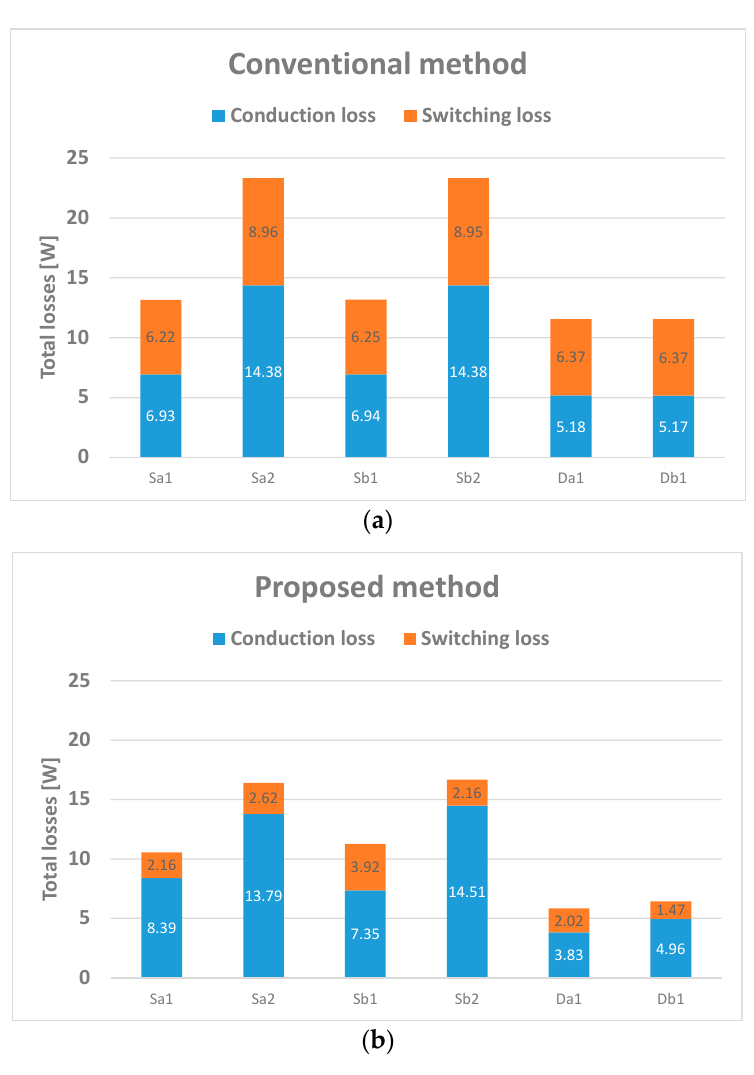
Figure 7. Loss comparison of ( a ) conventional method ( b ) proposed method.